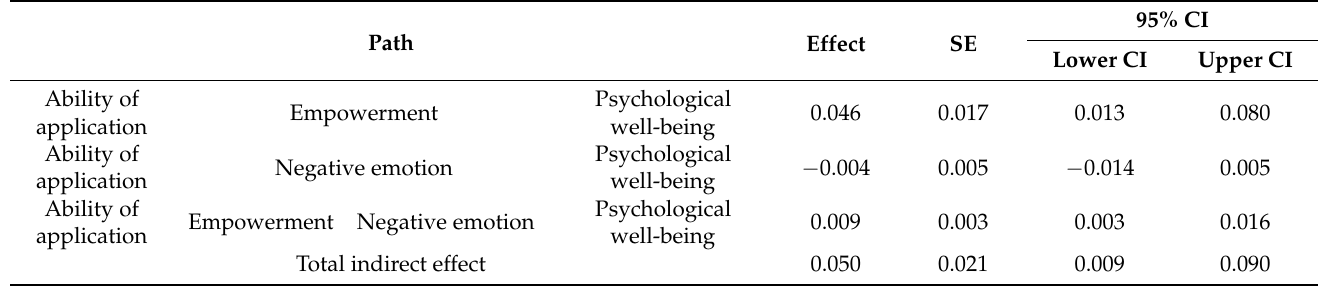
Table 3. Verification of indirect effect of empowerment and negative emotion.